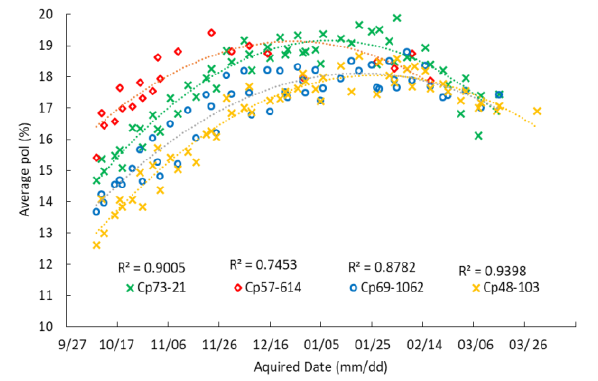
Figure 2. Average pol samples for four sugarcane varieties.